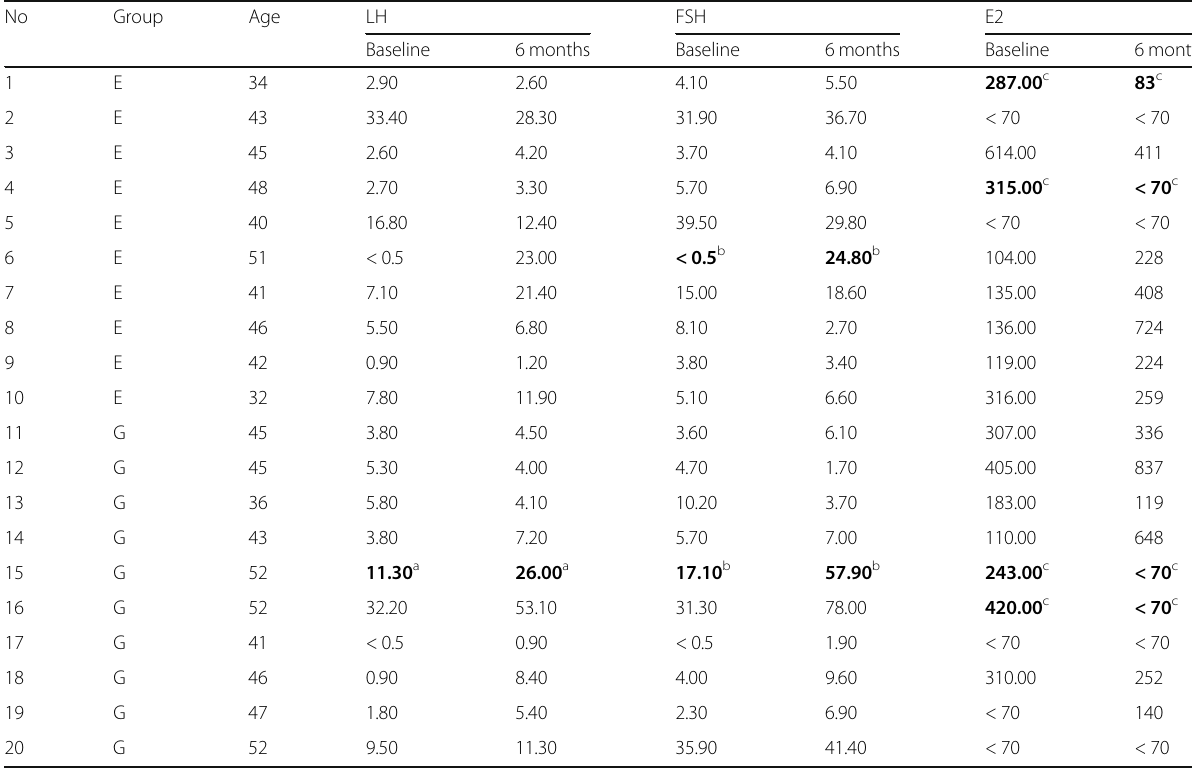
Table 4 Hormone levels at baseline and 6 months